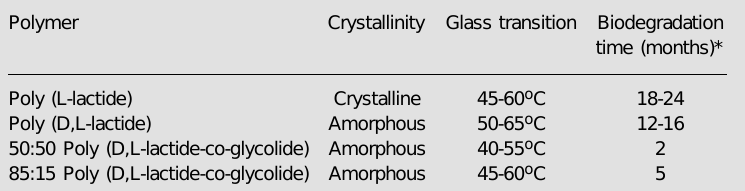
Table 1 – Physicochemical characteristics and biodegradation time of poly-lactide and co-polymers. *Biodegradation time depends on the formulation, porosity, surface area and polymer molecular weight. Adapted from Ref.